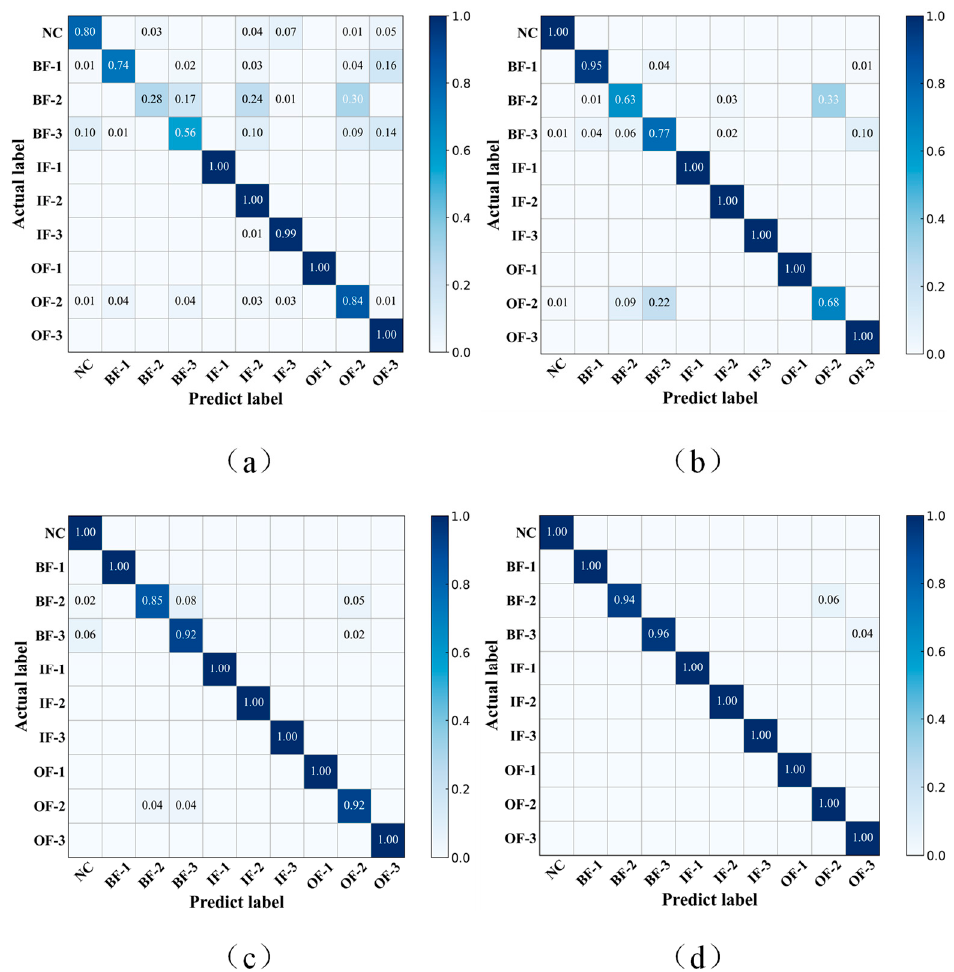
Figure 9. Confusion matrix using different methods. ( a – d ) correspond to the VGGNet, Conv5, ProtoNet-10 shot, and our method-10 shot.